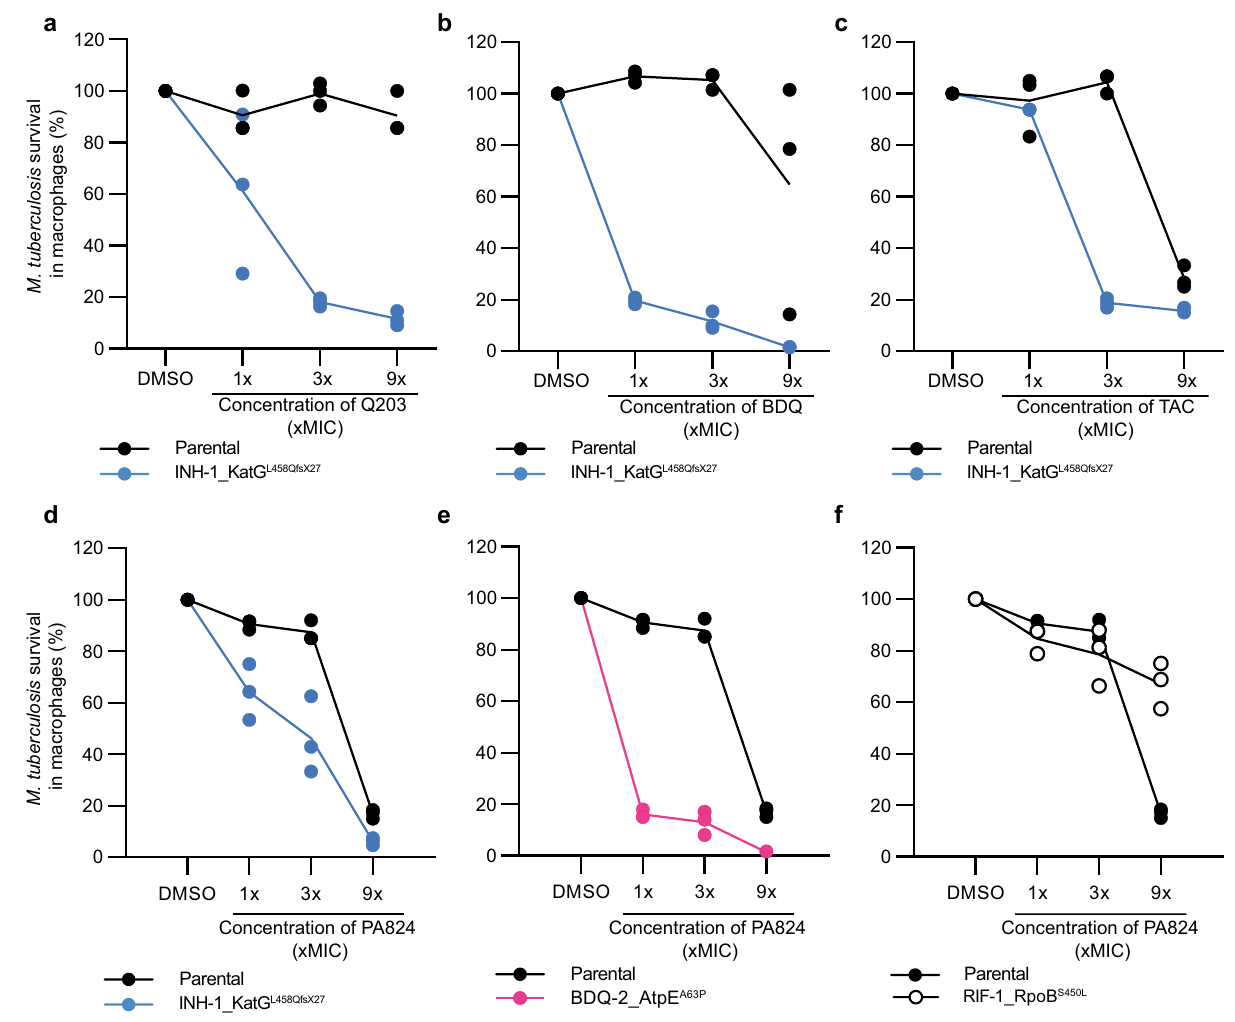
Fig. 5 | Collateral drug sensitivities are retained within infected THP-1 macro- phages. a – f The survival of intracellular M. tuberculosis drug-susceptible or resis- tant strains within THP-1 macrophages was determined after 3 days ofexposureto compounds at or above the MIC. MICs are as follows; Q203=0.05 µ M, BDQ=0.2 µ M, TAC=0.5 µ M, PA824=1 µ M. CFUs/mL were used to determine M. tuberculosis